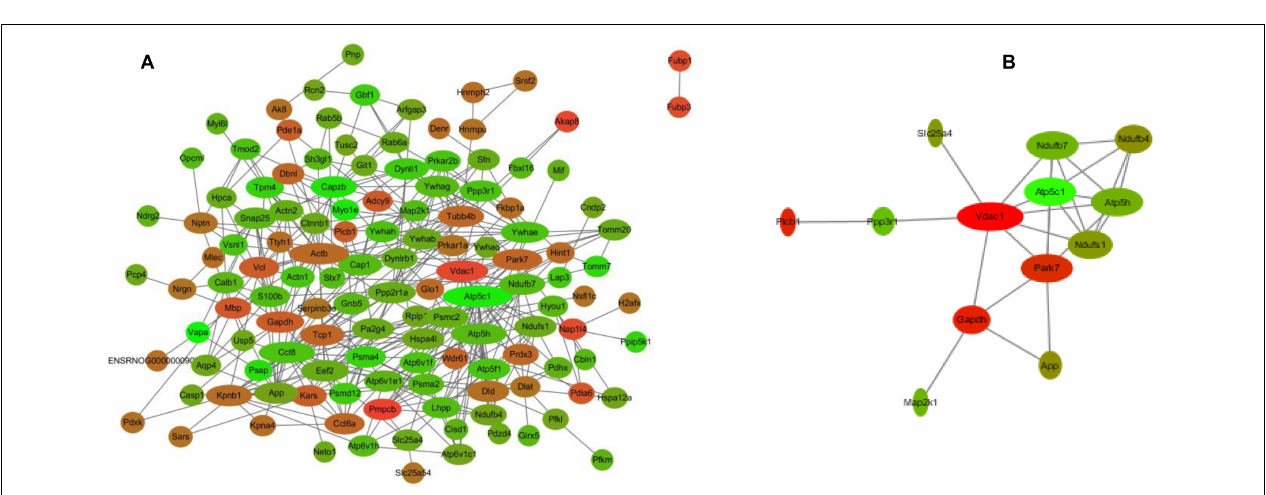
FIGURE 7 | The interaction network of differentially expressed proteins (DEPs) (A) and the interaction network of DEPs related to learning or memory and cyclic guanosine monophosphate–PKG pathway (B) . Network nodes represent proteins; edges represent protein–protein associations. Red, significantly increased; green, significantly decreased; width,